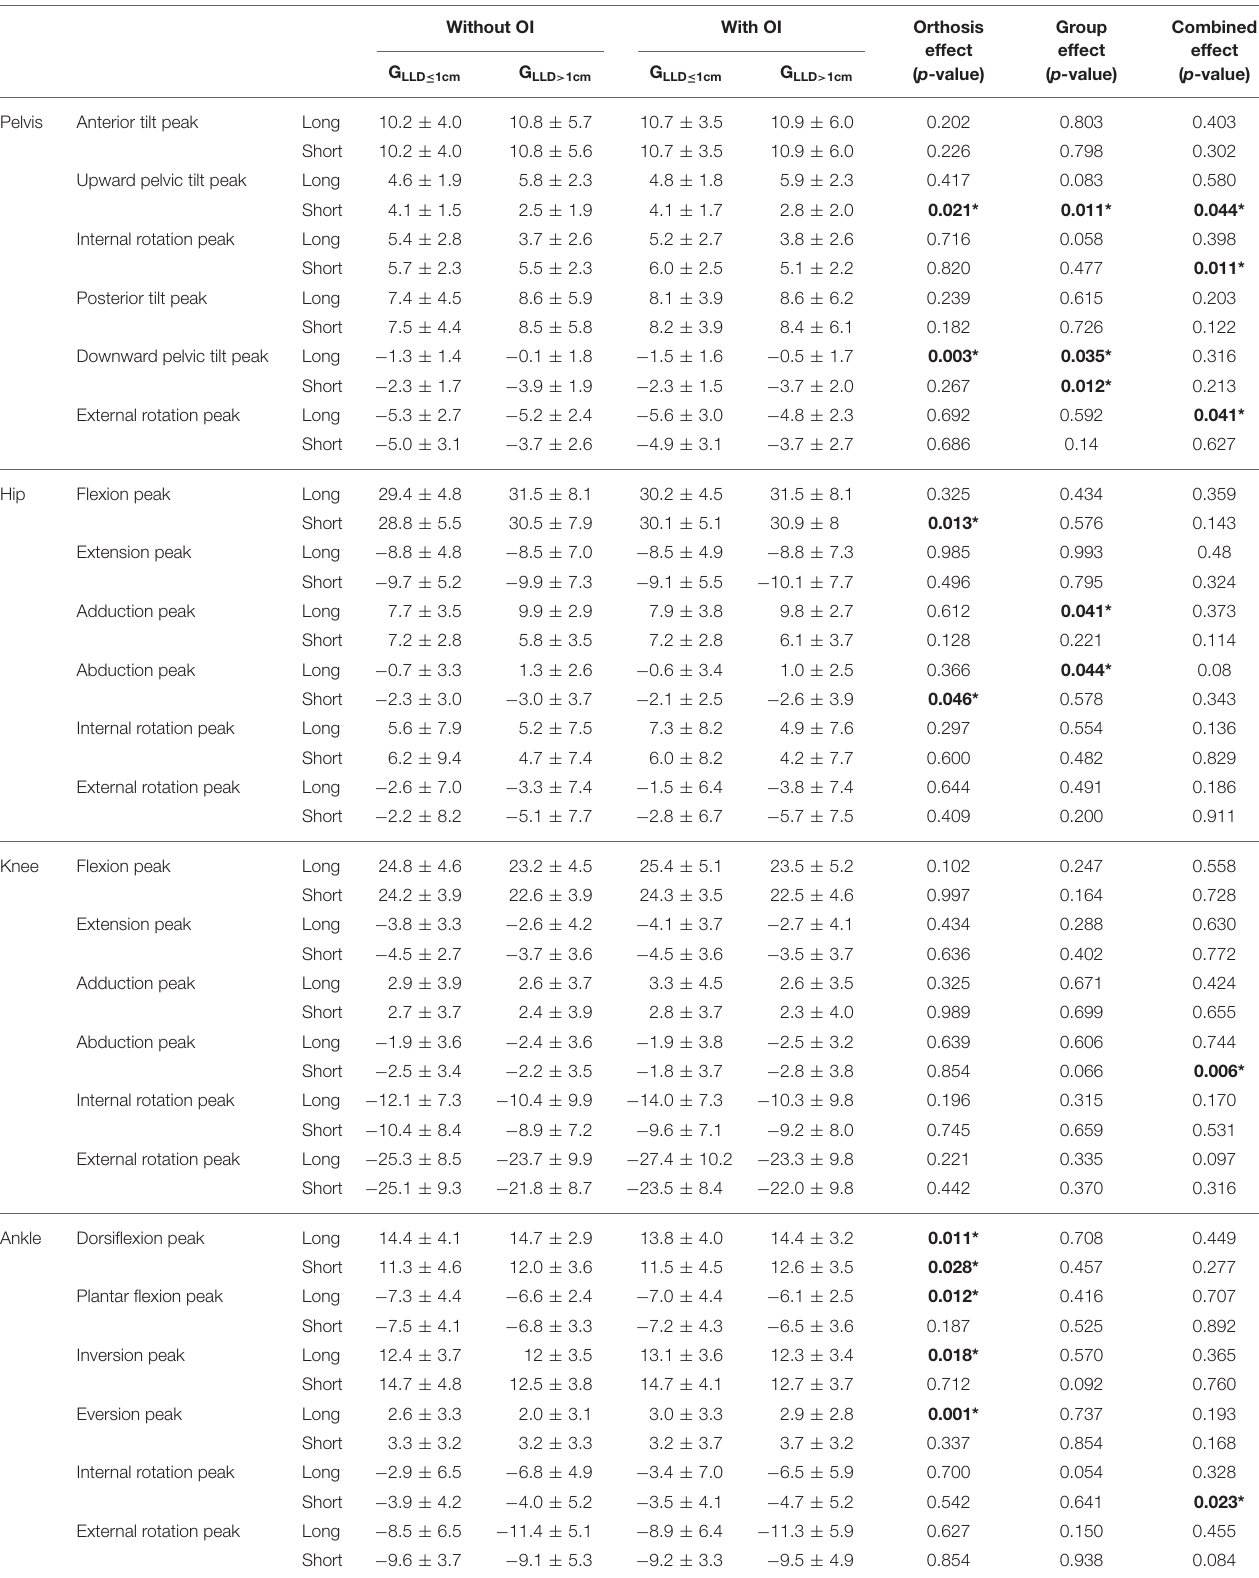
TABLE 3 | Peak stance phase angles of the pelvis, hip, knee, and ankle joints for each leg with and without orthotic insoles (OIs) for both groups. Without OI With